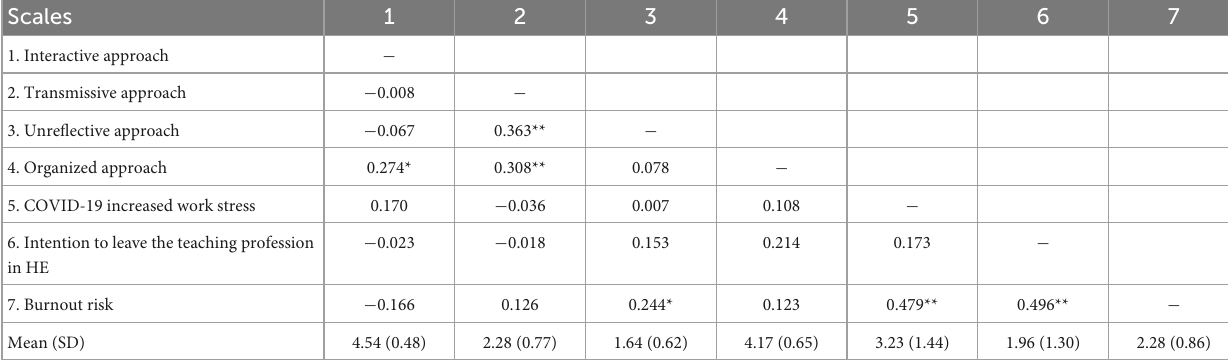
TABLE 1 The Pearson correlation coefficients between the approaches to teaching, stress caused by COVID-19, intention to leave teaching, and teaching-based burnout risk, means, and SD of scales. Scales 1